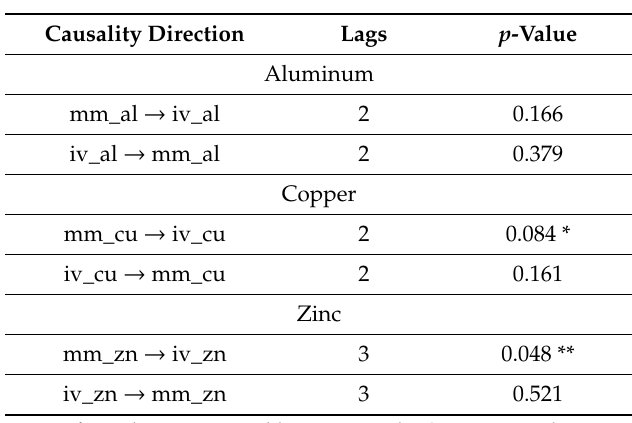
Table 3. Granger causality tests: Second